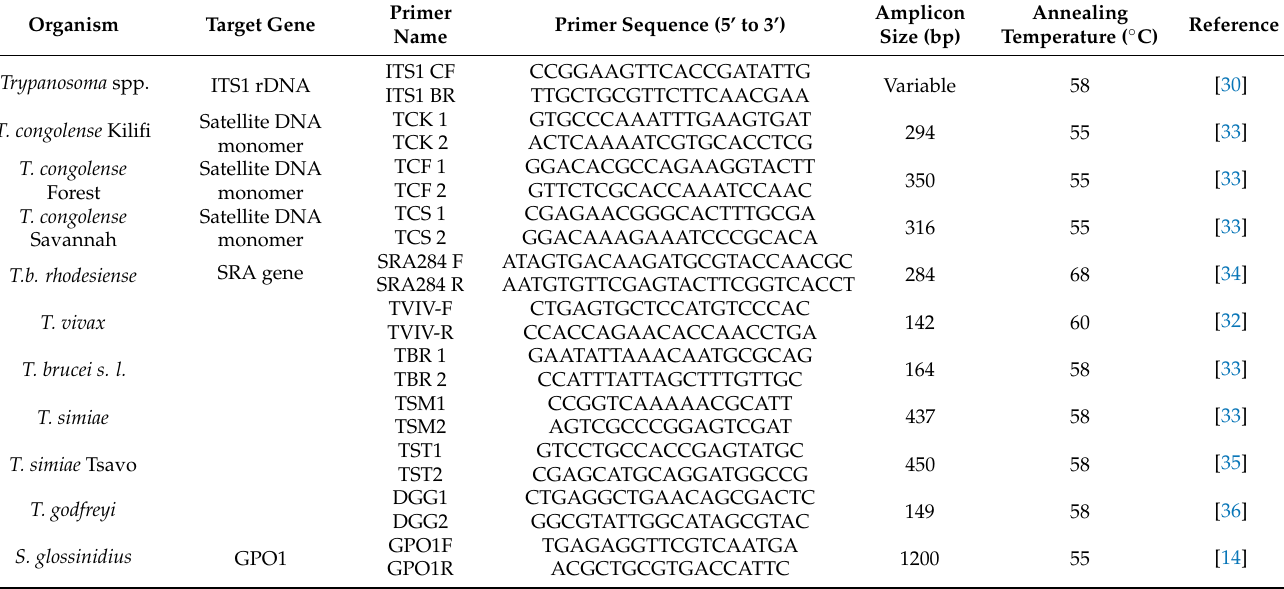
Table 1. Primers